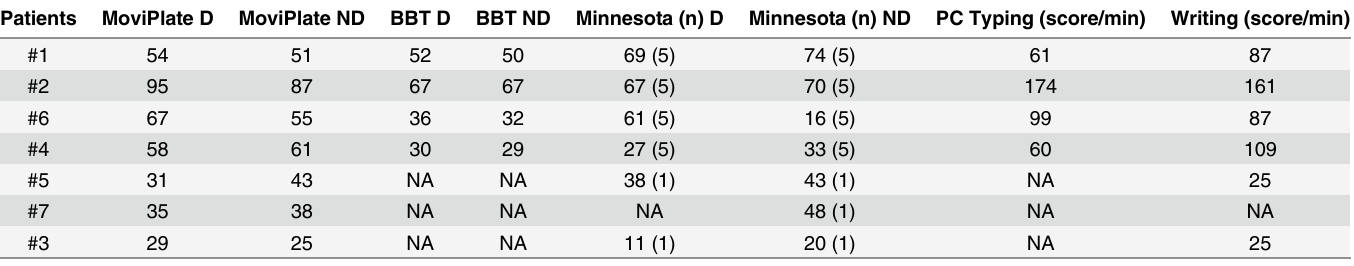
Table 2. The maximal scores on tasks completed by each patient at the two visits sorted by the decreasing age. Patients MoviPlate